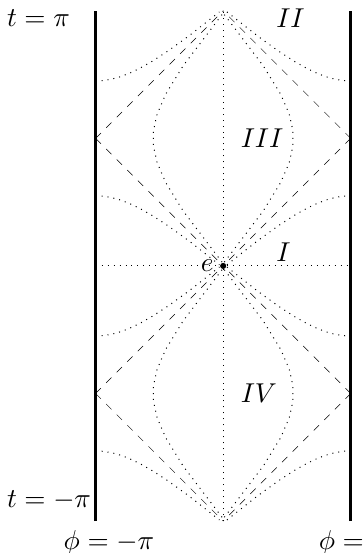
Figure 1. The group manifold of SL(2 , R ) , which is also the Penrose diagram of AdS 3 . The dotted lines represent the action of the group elements of SL(2 , R ) on the identity element e placed at the origin of AdS in global coordinates. The isometries of SL(2 , R ) are classified depending on which 3 region the element e is mapped to. Dashed lines represent null